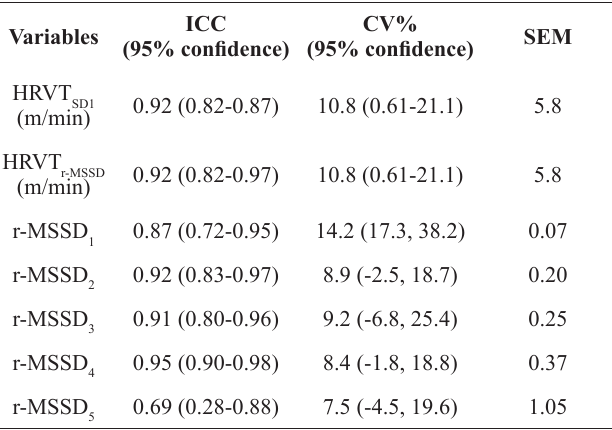
Table 3: Absolute and relative reproducibility of heart rate variability threshold and post-exercise r-MSSD analysis.